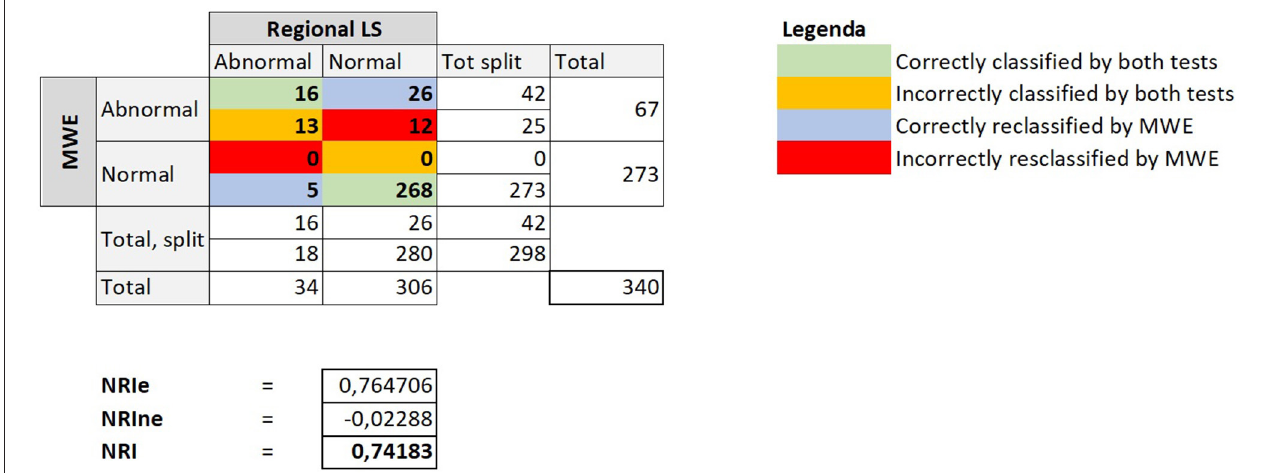
FIGURE 5 | The figure depicts the crosstab comparing the diagnostic classification obtained using regional LS or alternatively regional MWE to identify CAST. The reclassification indices are reported below the tab. MWE, Myocardial Work Efficiency; LS, Longitudinal Strain; CAST, critical coronary stenosis; NRI, net reclassification improvement; NRIe, NRI event; NRIne, NRI no event.